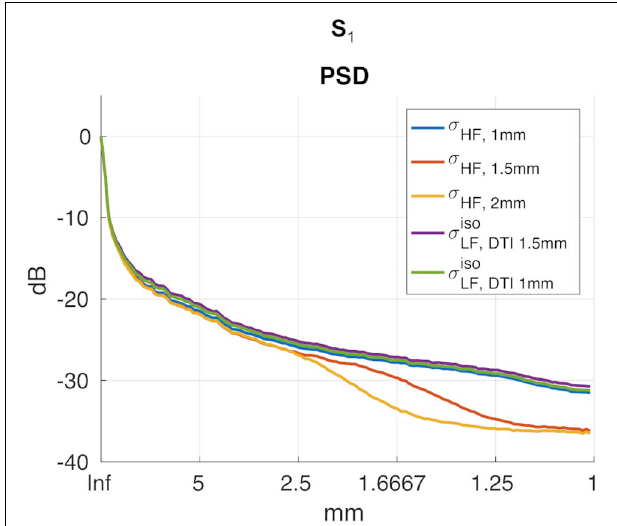
FIGURE 5 | PSDs for σ HF , 1 mm , σ HF , 1 . 5 mm , σ HF , 2 mm , σ iso LF , DTI 1 . 5 mm and σ iso LF , DTI 1 mm in subject